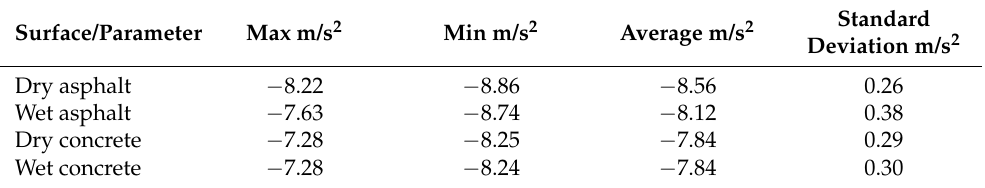
Table 3. Statistical characteristics of the acceleration value in the braking maneuvers of the coach.